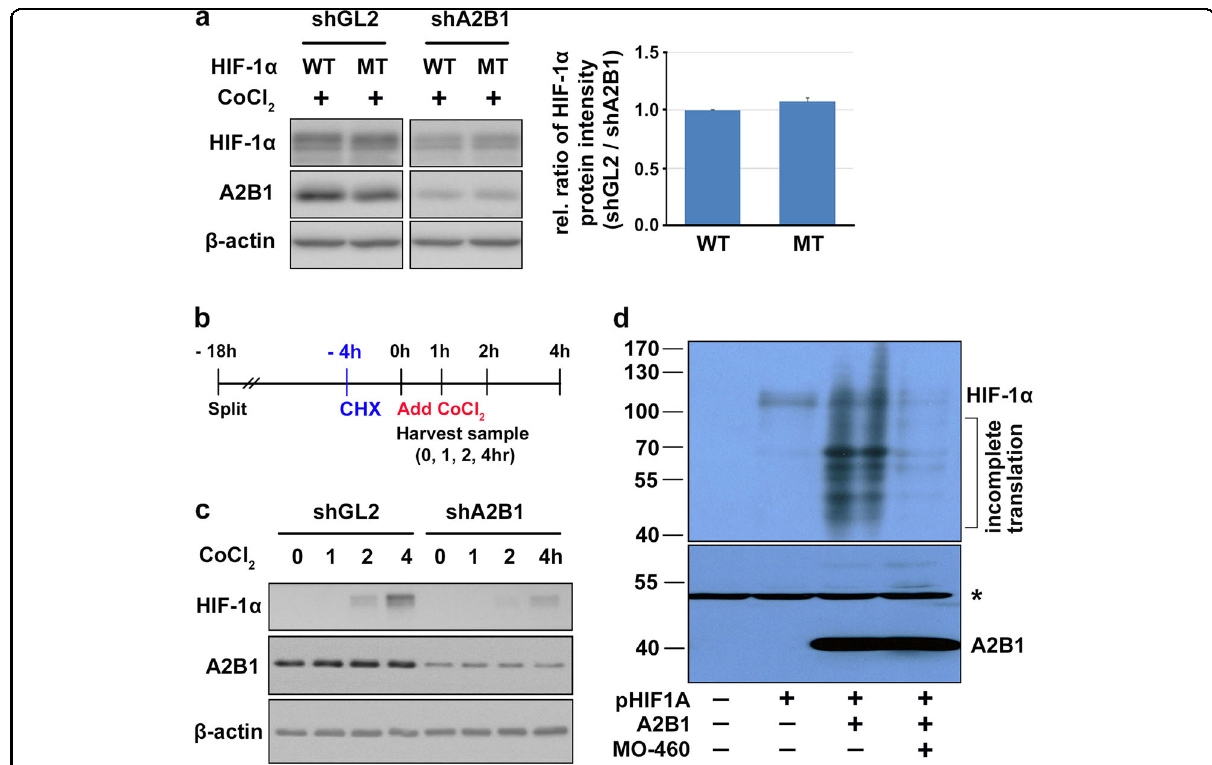
Fig. 5 Inhibitory effect of MO-460 on HIF-1 α protein levels occurs at the protein level. a Protein levels of hnRNPA2B1 (A2B1) and P402A/P564A mutant (MT) and wild-type HIF-1 α in shGL2 (control) and shA2B1 stable cell lines under mimetic hypoxia were assessed by western blotting and the relative ratio of MT and WT HIF-1 α in control and shA2B1 cells lines were quanti fi ed. b Schedule of newly synthesized HIF-1 α protein experiments by CoCl 2 . Cycloheximide (CHX) was treated 4 h before adding CoCl 2 for inhibiting de novo synthesis. c Western blotting of newly synthesized HIF-1 α protein was performed in shGL or shhnRNPA2B1 stable cell lines. d In vitro transcription/translation assay of HIF-1 α was performed in the presence or absence of hnRNPA2B1 protein and MO-460. Western blotting was performed with an anti-HIF-1 α . Asterisk (*) indicates non-speci fi c